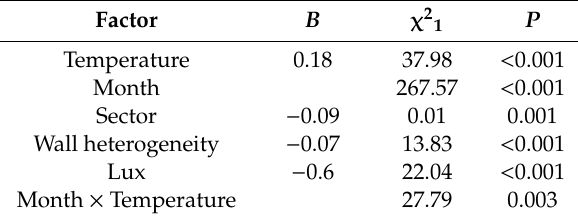
Table 3. Parameters related to the presence of crane flies within cave sectors. The significance of variables included in the best AICc model are shown; significant variables are in